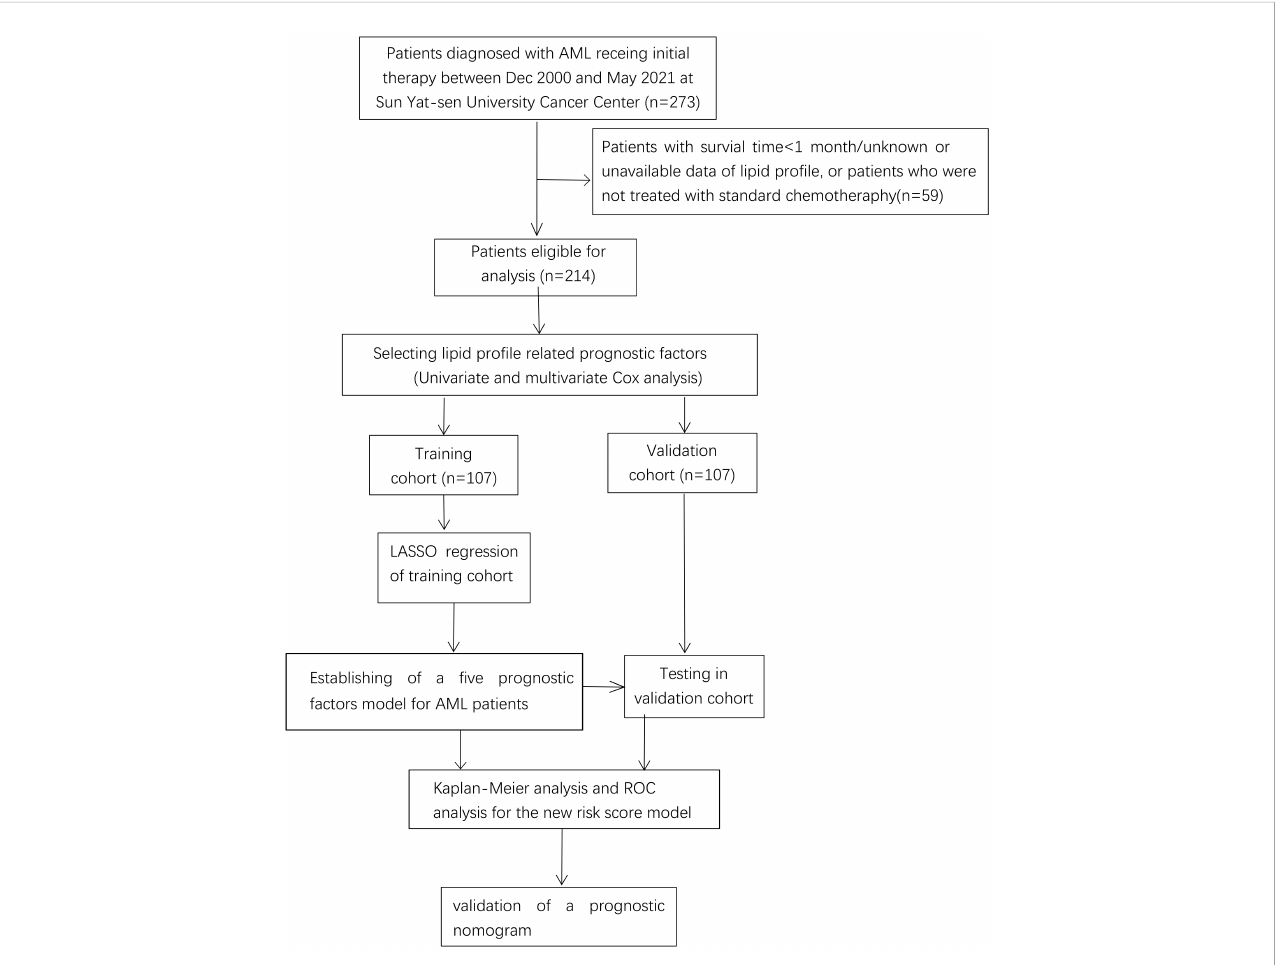
FIGURE 1 Flow chart of data collection and